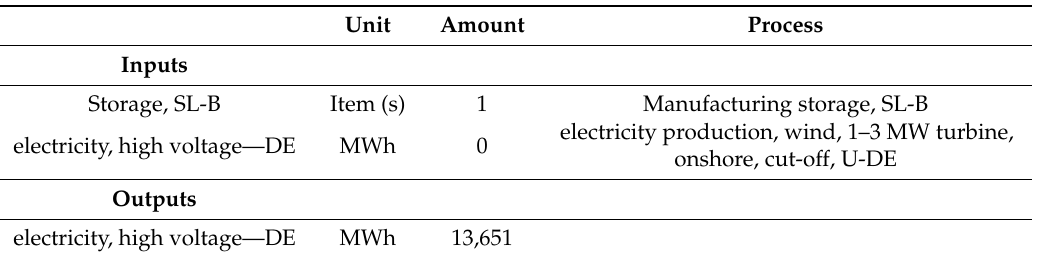
Table A33. Use Storage,